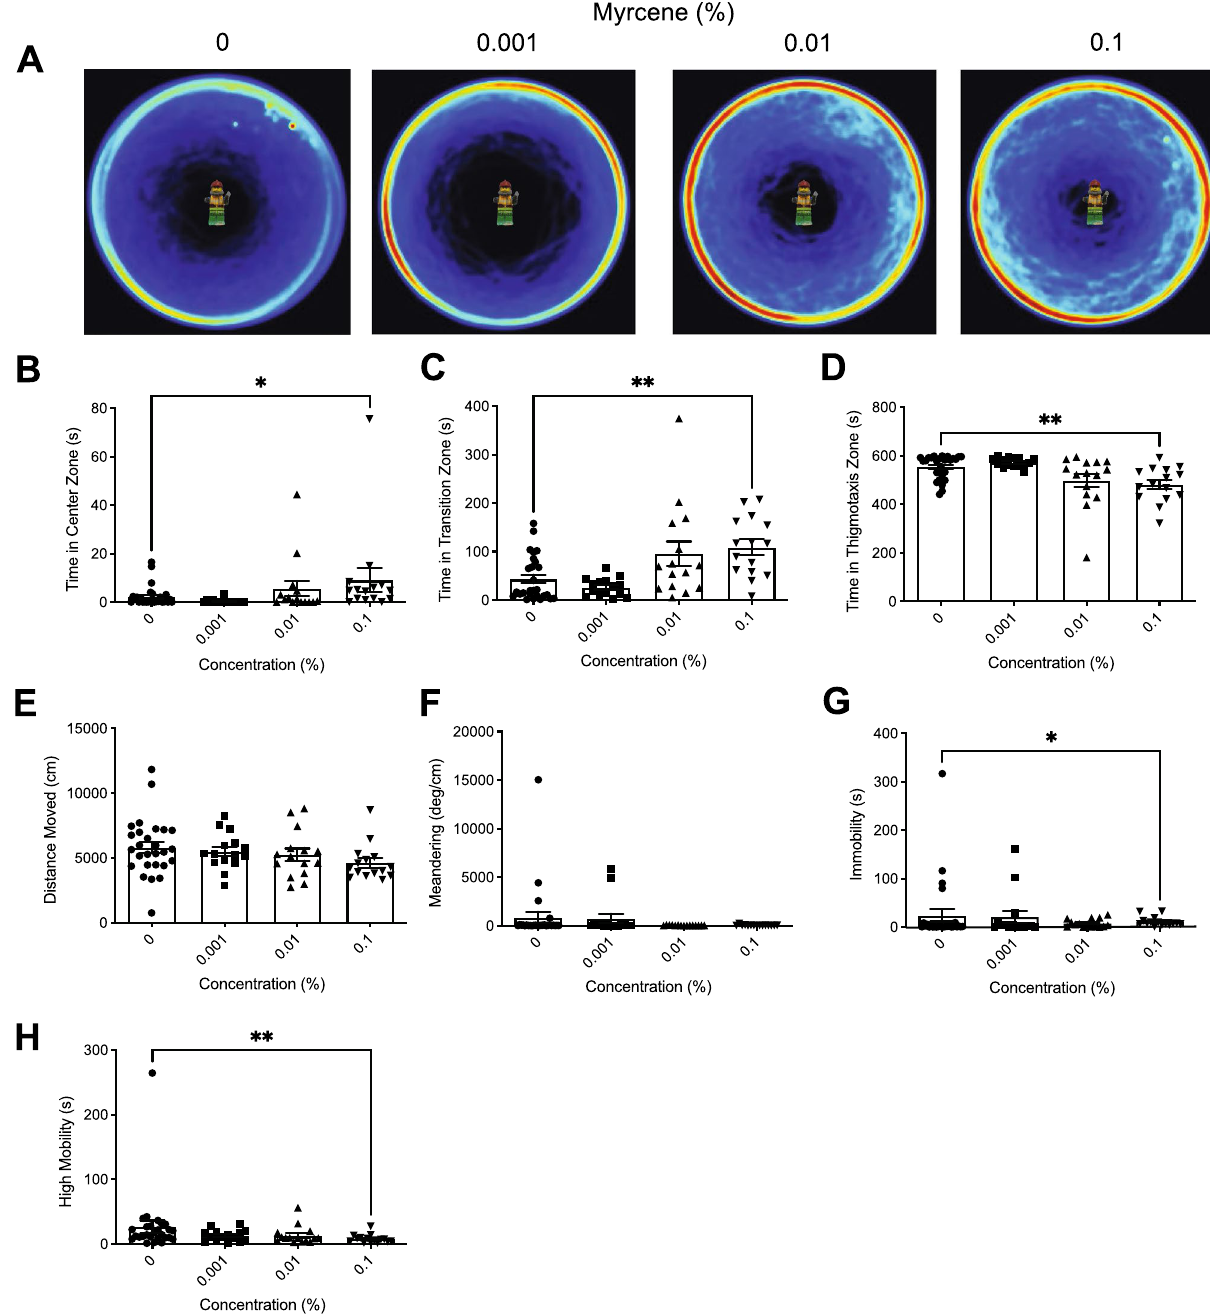
Figure 6. The effects of acute β-myrcene administration on zebrafish behaviour assessed by the novel object approach test. ( A ) Group heatmaps showing a coloured representation of the combined mean location of each group of fish across all trials. Average time spent in the center ( B ), transition ( C ), and thigmotaxis ( D ) zone during the novel object approach test. Fish locomotion was quantified in the novel object approach test by measuring distance moved ( E ), meandering ( F ), time spent immobile ( G ), and time spent highly mobile ( H ). All data are presented as mean ± S.E.M. Significant differences between controls and β-myrcene treated groups are indicated by *( P < 0.05) and **( P <